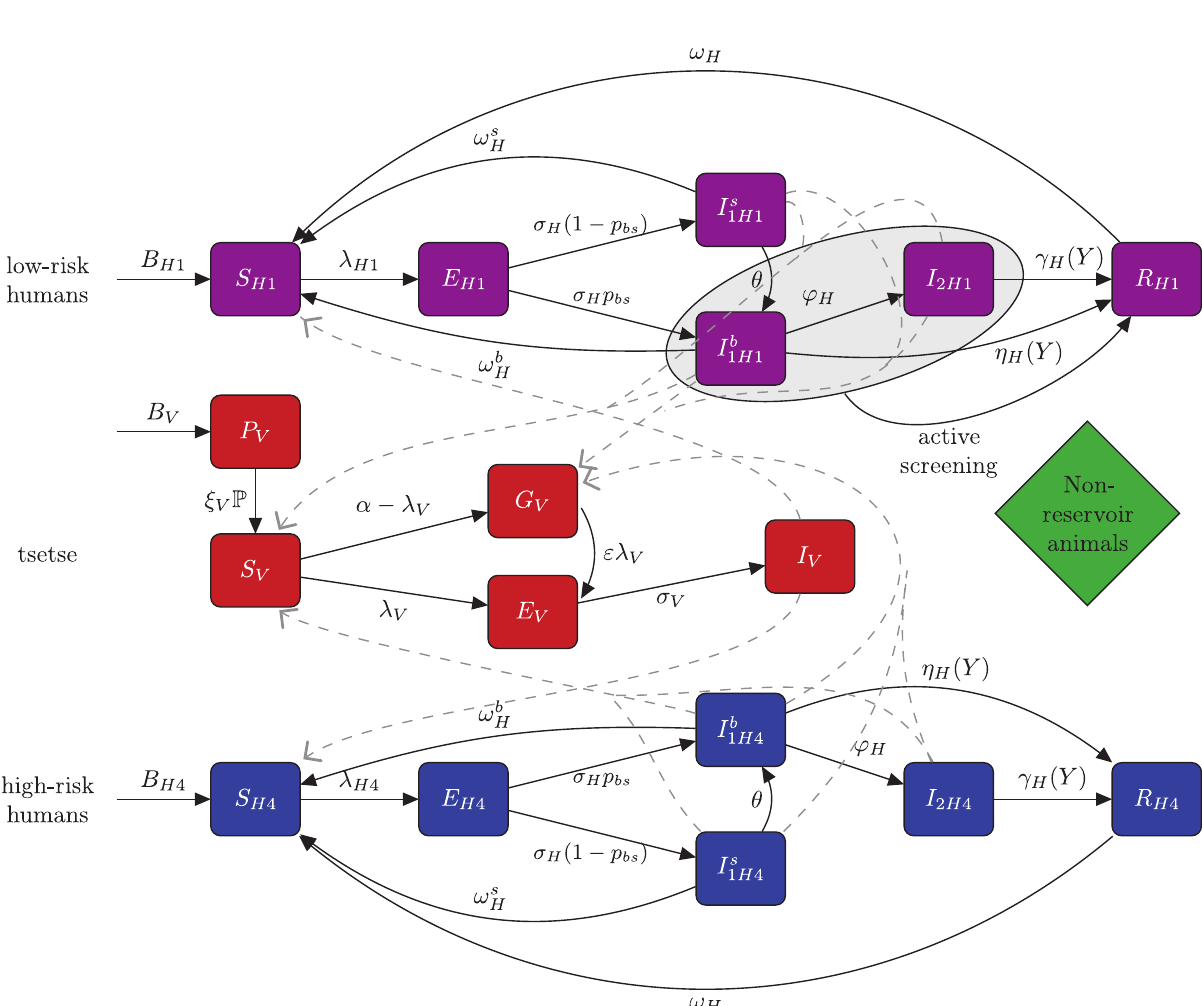
Fig 1. Schematic of the model to describe gHAT transmission with asymptomatic infections. This multi-host model of HAT takes into account high- and low-risk groups of humans and their interactions with tsetse vectors. Each group consists of different compartments: Susceptible humans S Hi can become exposed on a bite of an infectious tsetse. Exposed people E progress to become the skin-only parasite I s or blood parasite stage 1 Hi 1 Hi infection I b ; the latter eventually develops stage 2 (if not detected in screening), and once treated they recover by hospitalisation R . Active screening Hi 1 Hi can accelerate treatment rate of infected people, but only in those with detectable blood infection and in the low-risk group— I b and I 2 H 1 . This is 1 H 1 marked on the diagram as a grey oval. Here we assume high-risk group does not participate in active screening. By biting an infectious person, tsetse can become exposed and subsequently infectious, E V and I V . G V represents the tsetse population not exposed to Trypanosoma brucei gambiense in the first blood-meal and are therefore less susceptible in the following meals. Rates are shown by Greek letters associated with arrows. An animal reservoir is not considered. This figure is a modified version of the original one [22,